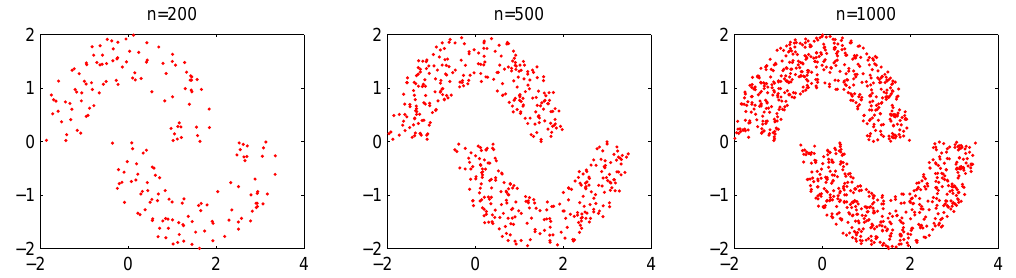
Figure 17. Synthetic dataset with different data numbers from 200 to